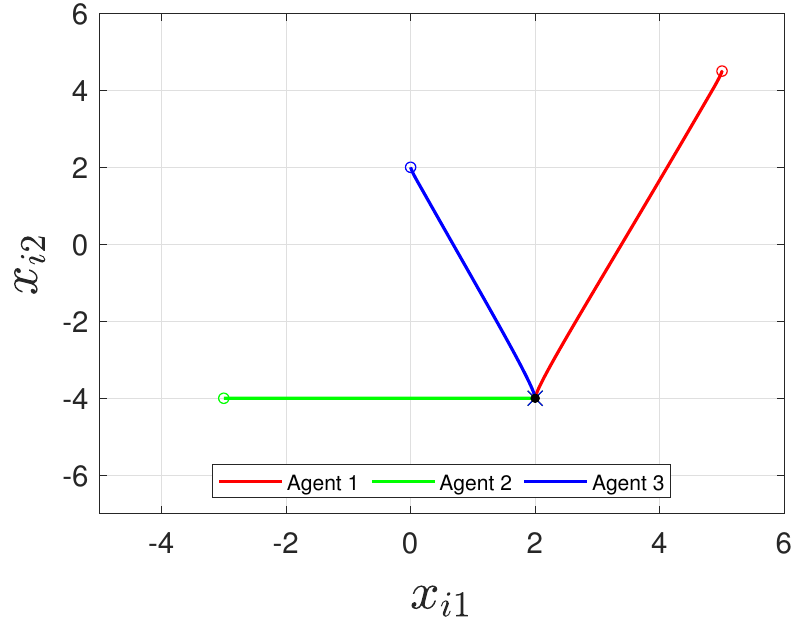
Figure 5. Phase plane where ◦ (Initial state), × (Final state), and • (Global